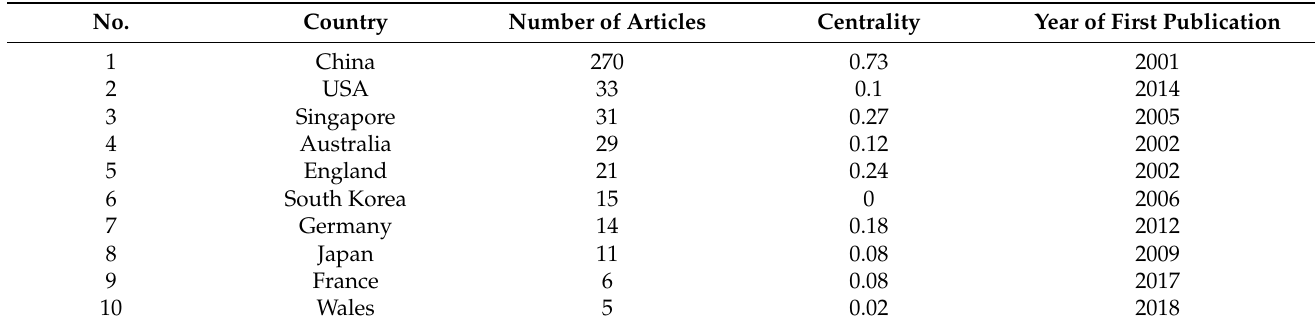
Figure 4. Knowledge map of regions most contributing to high-density city research from 2001 to 2022. Table 3. Regions most contributing to high-density city research from 2001 to